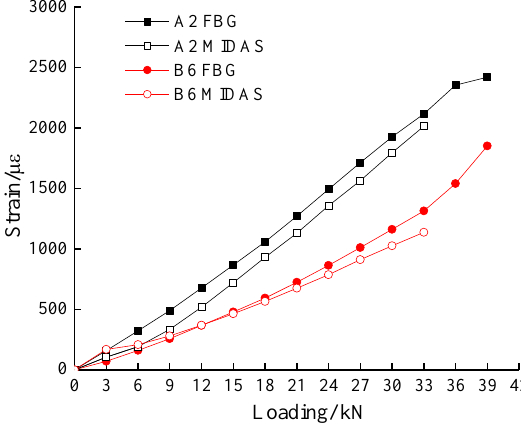
Figure 8. The comparison of test and numerical simulation results.